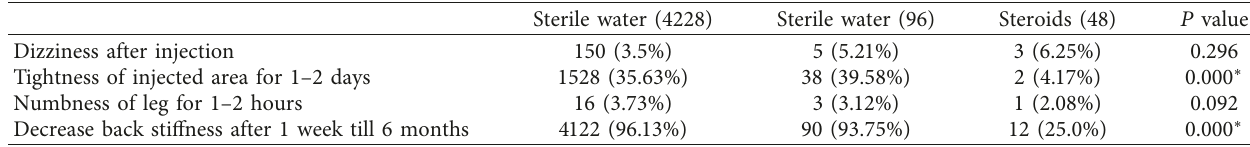
Figure 4: The comparison within group (a) and between groups (b) of walking distance at 6 time points as preinjection (T0), immediately (T1), one week (T2), 1 month (T3), 3 months (T4), and 6 months (T5) after injection. Table 3: Symptoms after